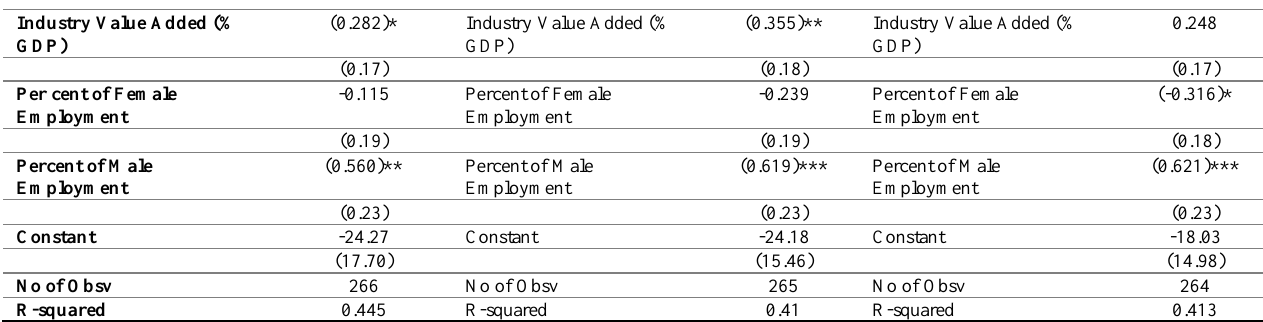
Estimated results of the Model at Poverty headcount ratio $ 3.2